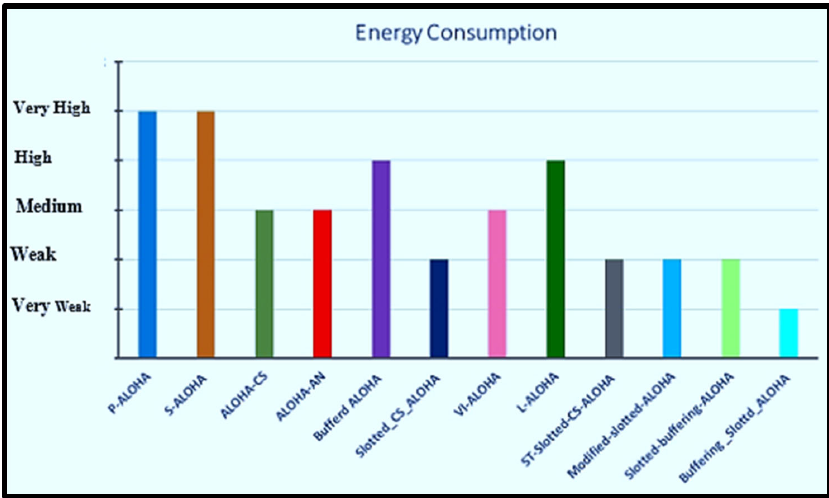
Figure 10. Comparison of energy consumption between different ALOHA protocols.